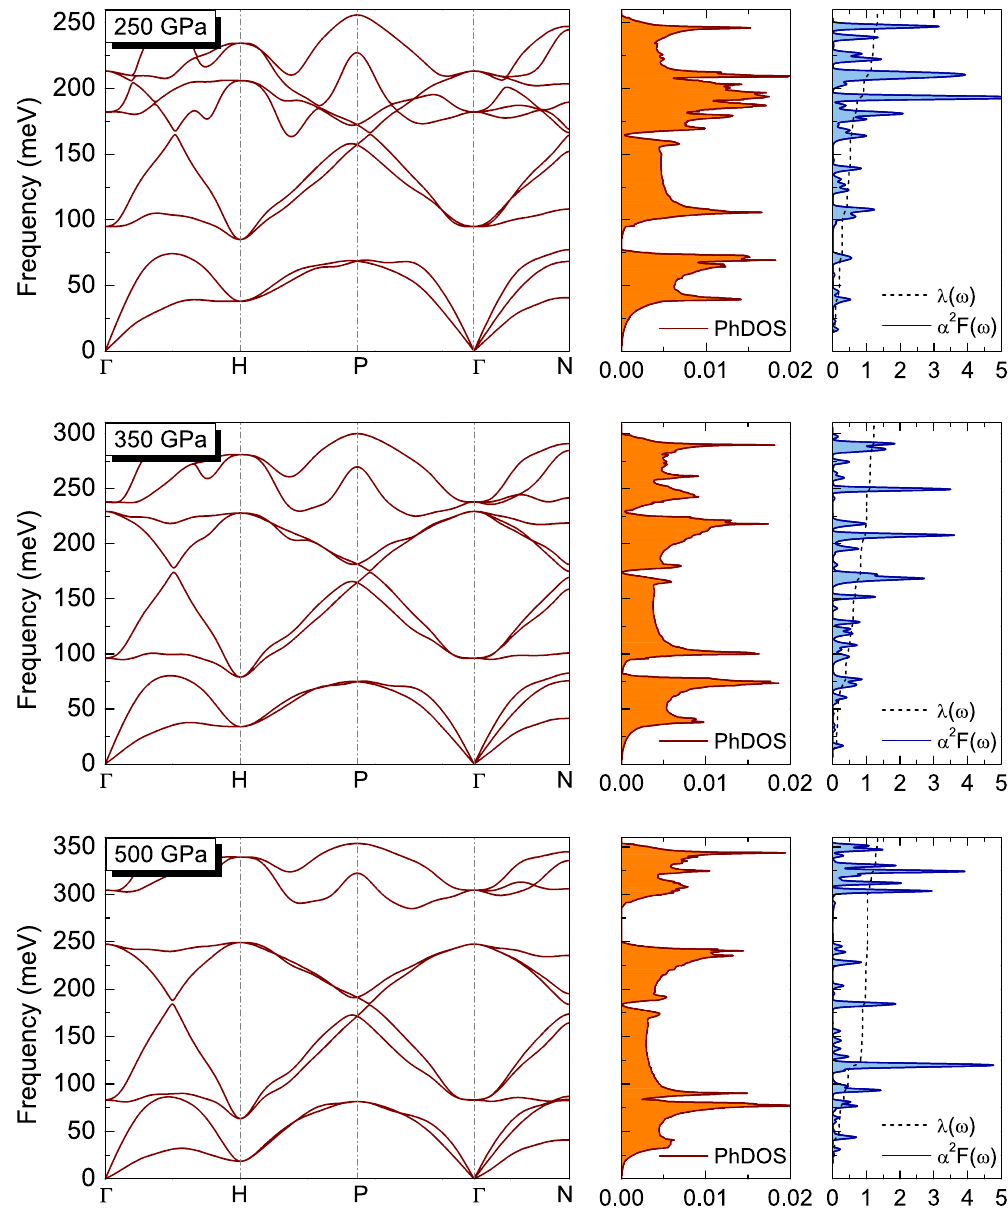
Figure 5. The phonon dispersion relation, the phonon density of states, and the spectral functions for selected values of